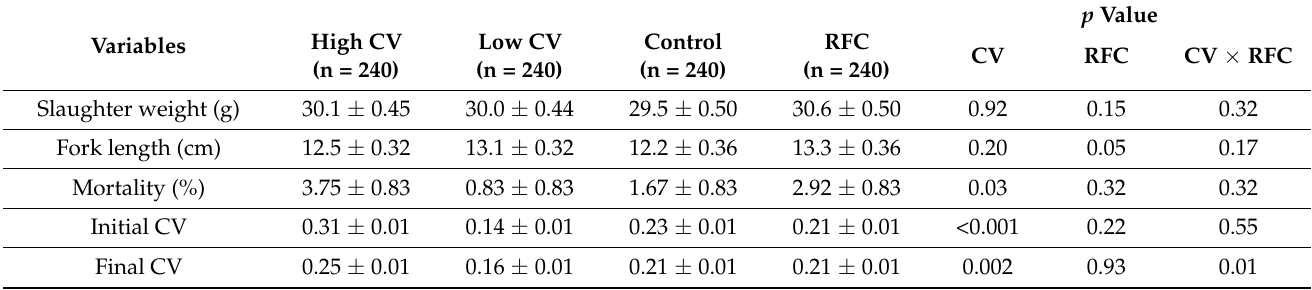
Table 1. Mean ( ± SEM) growth data of rainbow trout from Trial 1 at the end of the trial for high CV and low CV groups and controls and trout in tanks with randomly fired currents (RFC), including the significance of the main effects and their interaction.